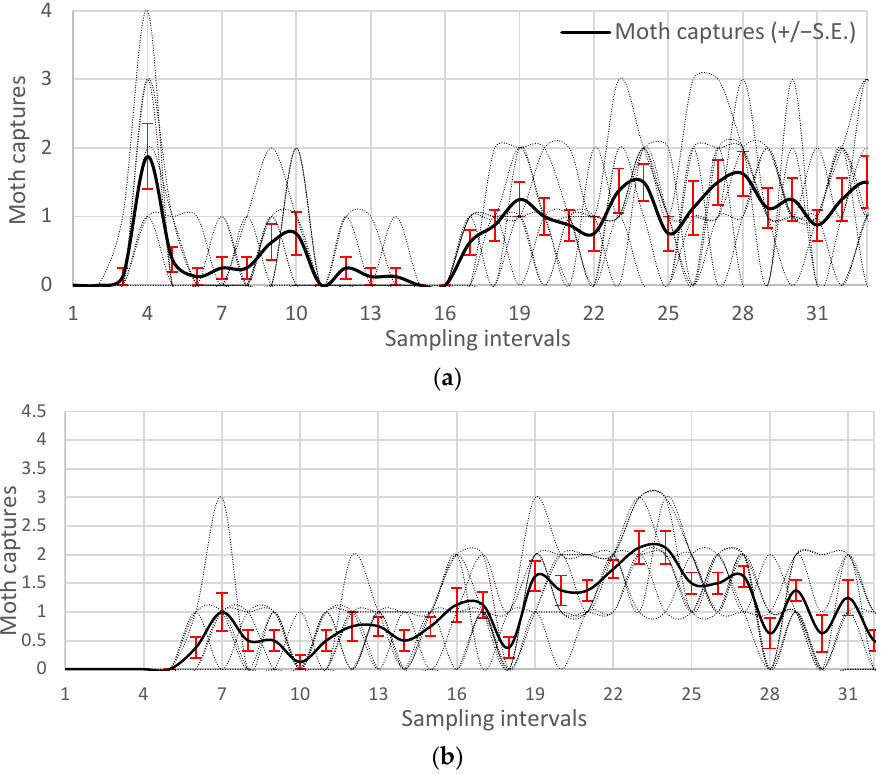
Figure 1. Seasonal flight patterns of H. armigera (black line) as observed with eight pheromone traps (dashed lines) placed in four experimental dry bean fields in the Prespa region of Northern Greece. Sampling intervals are 3-day observations starting from mid-April till end of August 2021 ( a ) and 2022 ( b ).